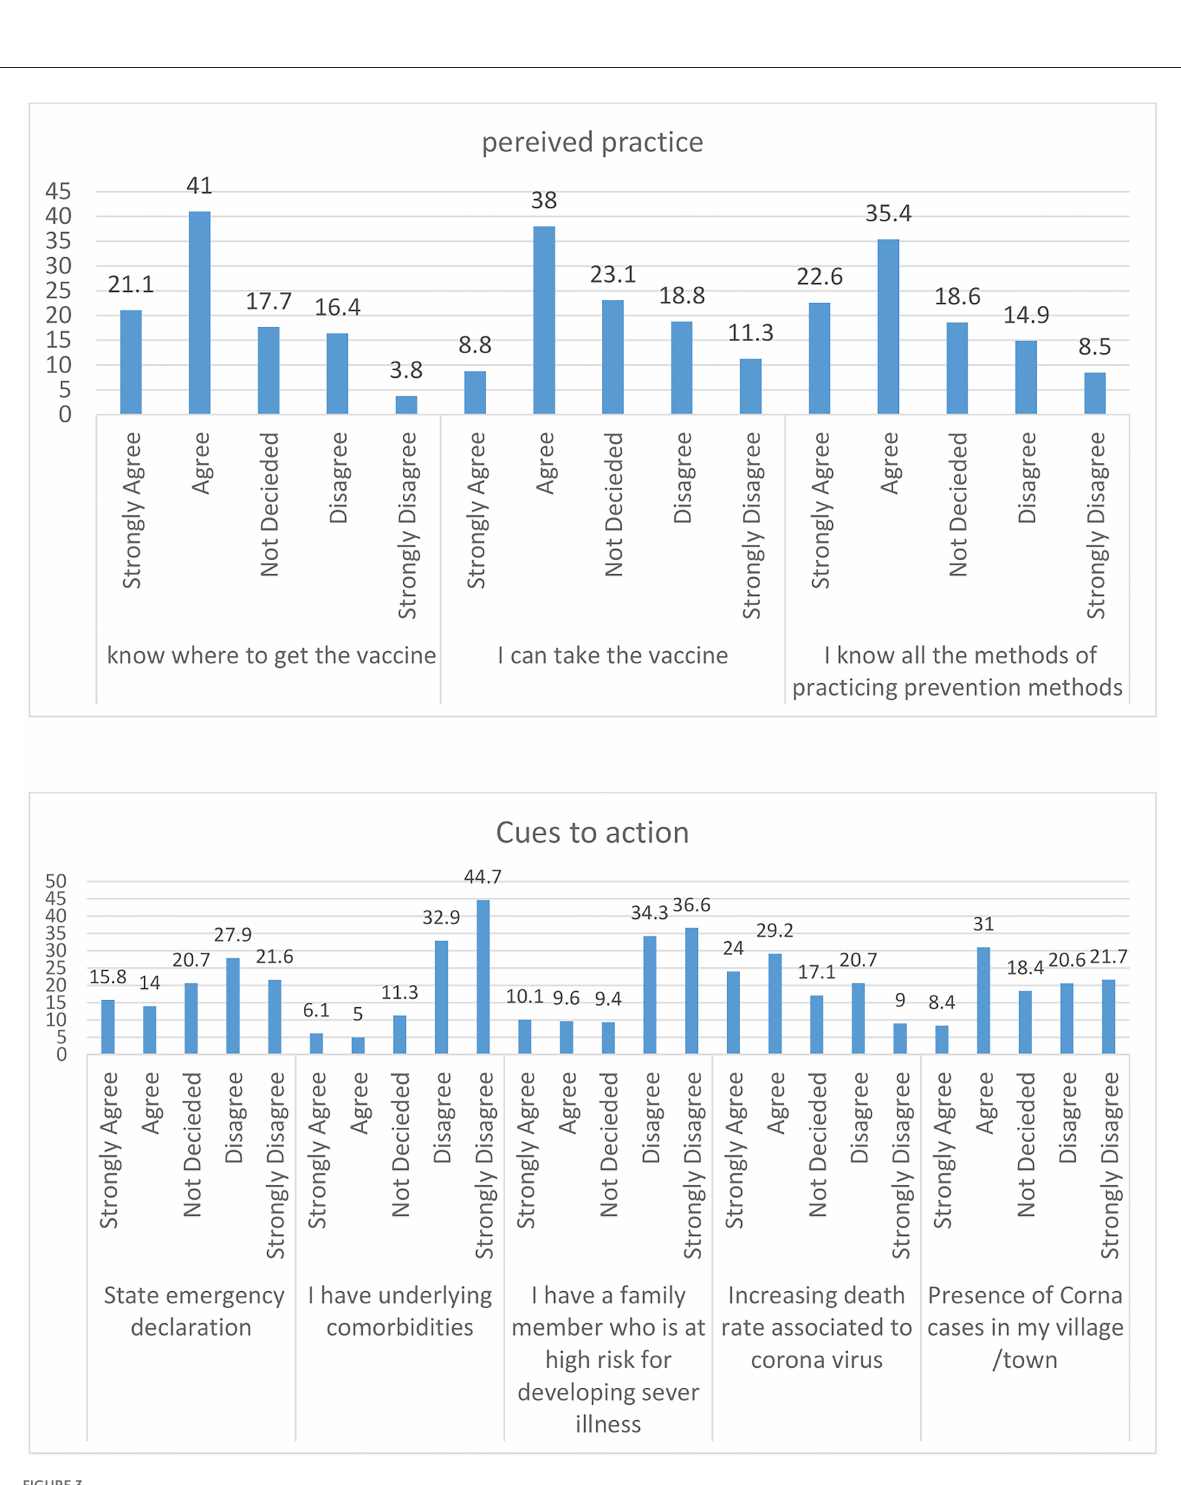
of the study participants agreed that they believe that it is a disease of GOD to punish us for our sins. Approximately 393 (35.4%) of the participants agreed that they know all the methods of practicing prevention methods and 442 (39.8%) of